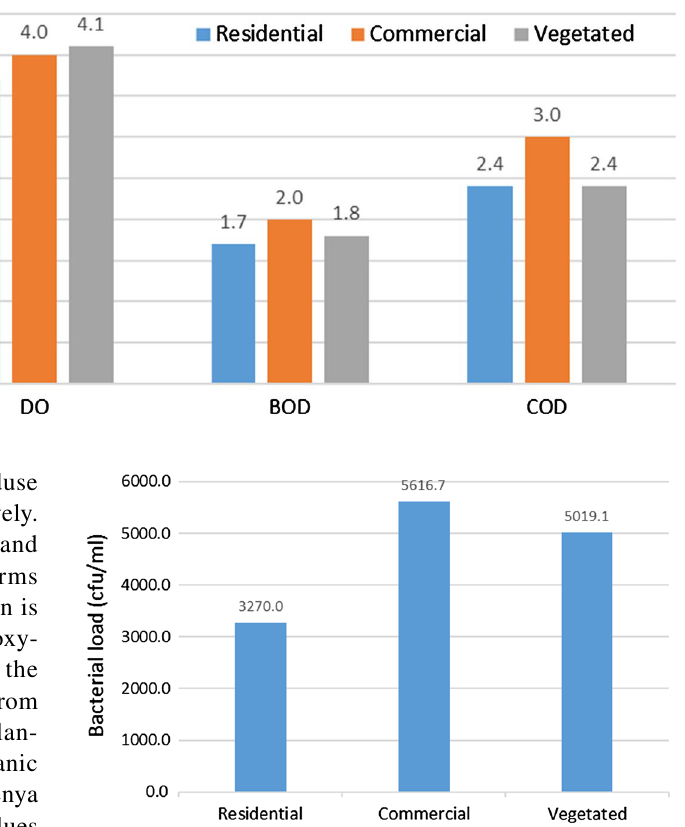
Fig. 10 Variation in bacterial load (fecal